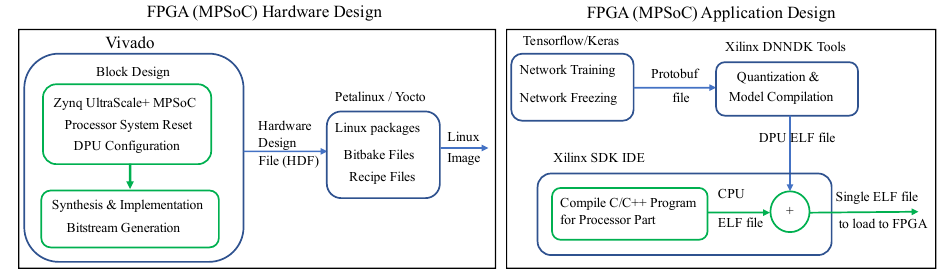
Figure 15. Hardware and Software Implementation Flow for MPSoC